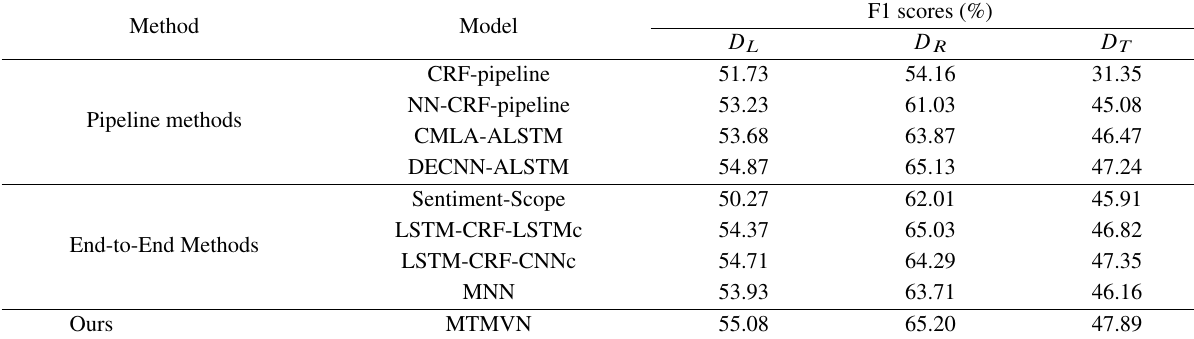
Table 4 Comparison results in the F1 scores (%) of all the baselines and our proposed model for the whole ABSA task.